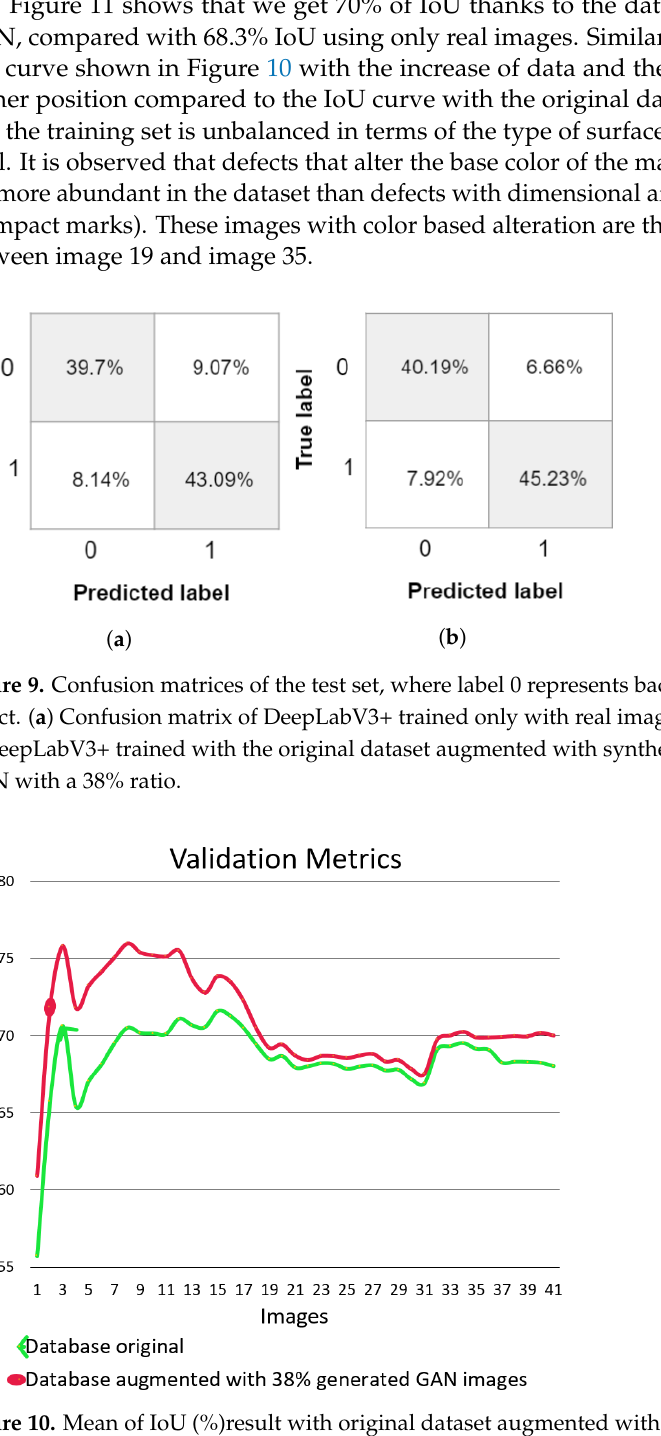
Figure 10. Mean of IoU (%)result with original dataset augmented with a conventional method and the original augmented with synthetic images generated by the GAN with a 38%